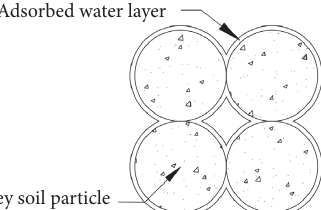
Figure 17: Adsorbed water layer on the surface of clayey soil